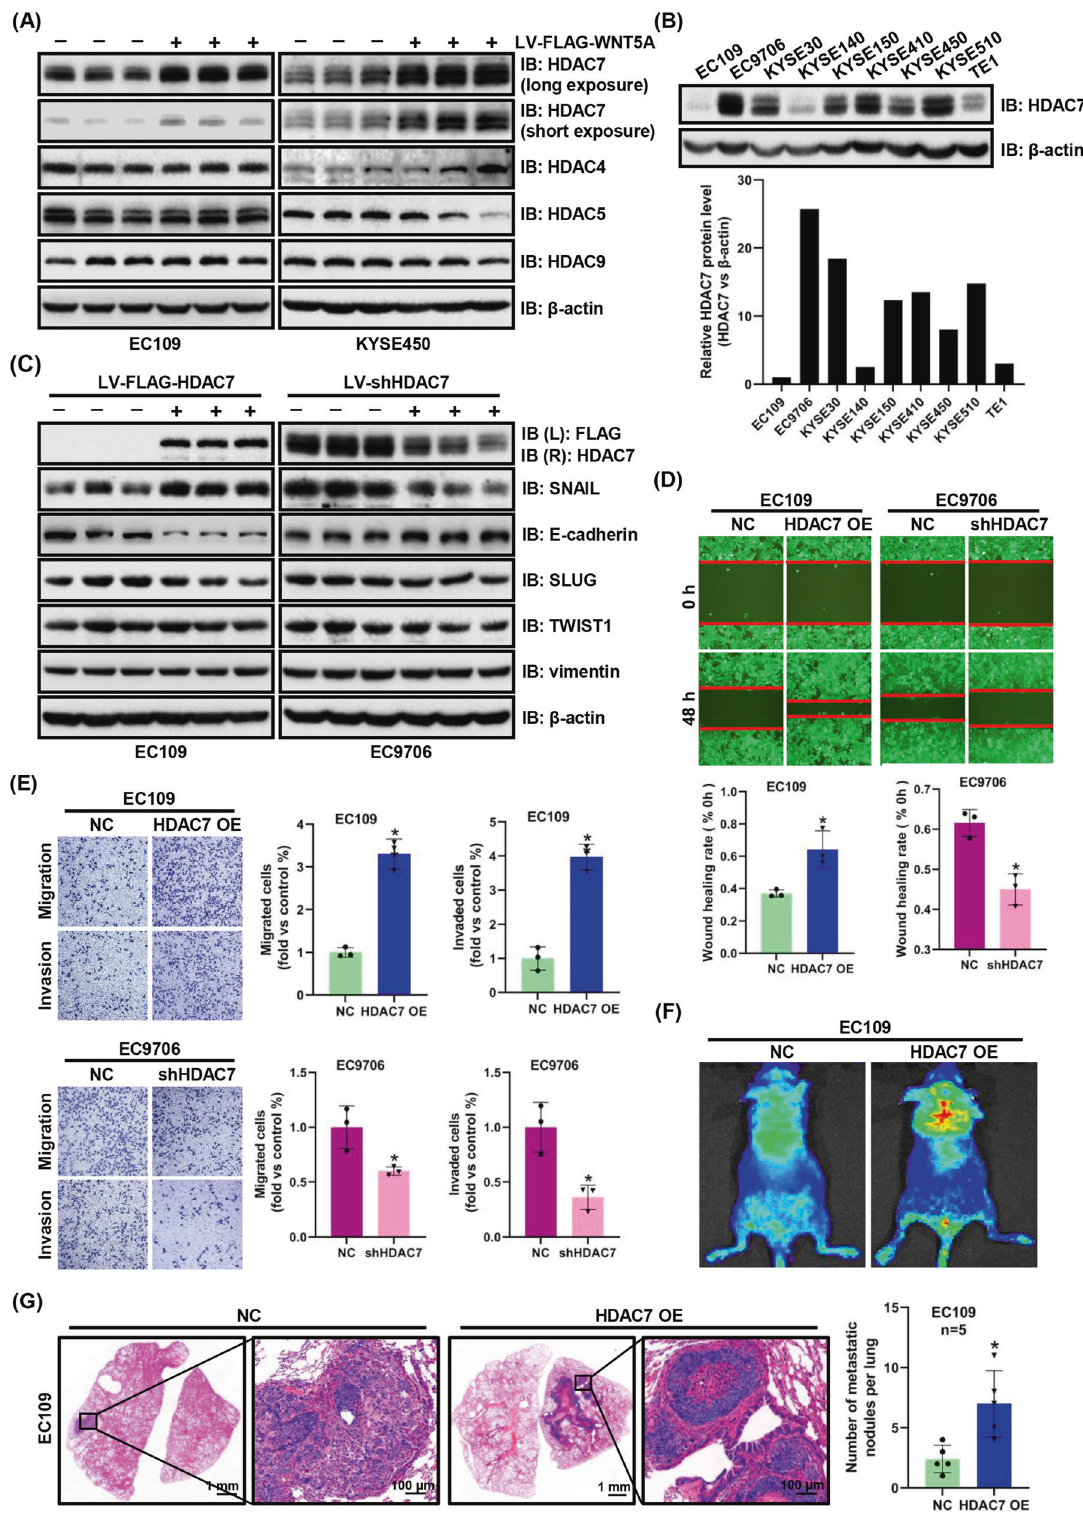
performing a nude mouse lung metastasis assay and found that overexpression of HDAC7 increased the incidence of lung metastasis, whereas loss of HDAC7 exerted the opposite effect (Fig. 4F, G and Supplementary Fig. S2G, H).